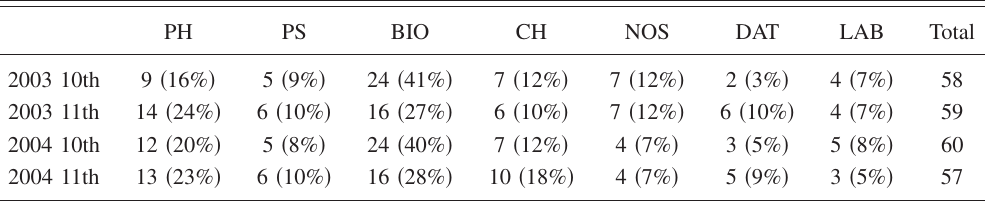
TABLE IV. Number of items with each content area code by year and grade level. Items classified as LAB also received a content area classification.